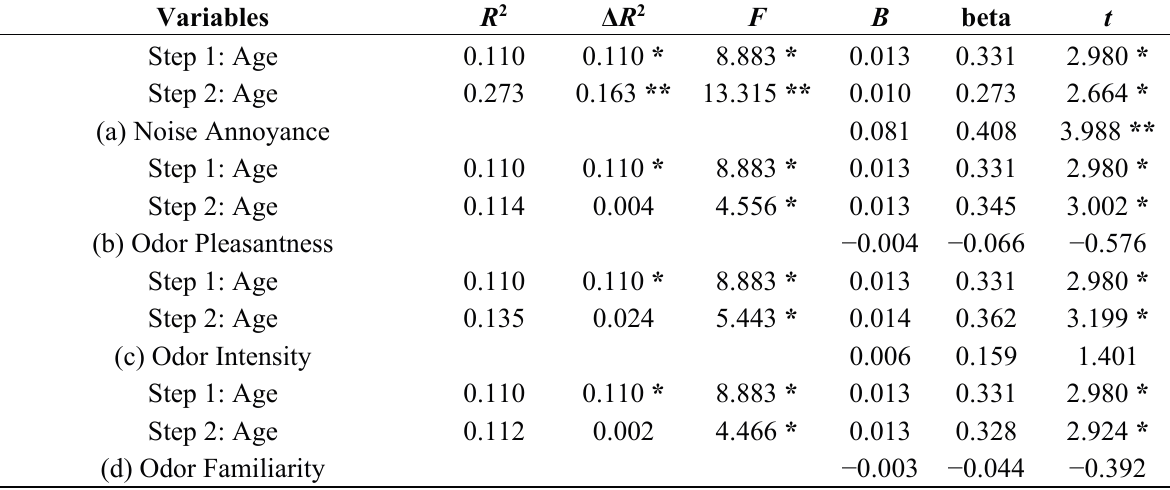
Table 2. Four Hierarchical multiple linear regressions between noise sensitivity (always the dependent variable) and (a) noise annoyance, (b) odor pleasantness, (c) odor intensity, and (d) odor familiarity. To control for participant age, it was always included in the first